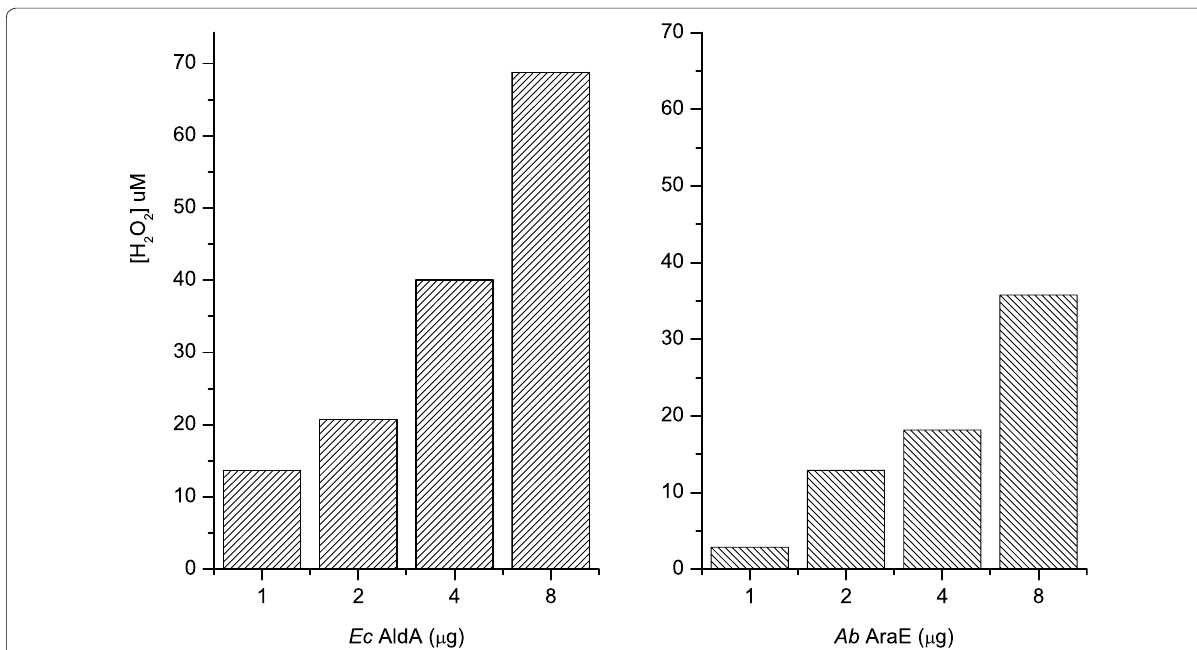
Fig. 8 Evaluation of the final dehydrogenase of the in vitro enzymatic pathway from d -xylose to glycolic acid. The in vitro pathway is composed of 5 enzymatic steps ( Cc XylB, Cc XylC, Cc XylD, Ec YagE and Ec AldA or Ab AraE). The production of glycolate was followed through an enzymatic assay using HAO1, which converts glycolate to glyoxylate and produced H 2 O 2 , which can be detected using HRP and Amplex red. The assay was performed as a two-step process as described in “Materials and methods”. The two final dehydrogenases of the pathway Ec AldA and Ab AraE are compared using this